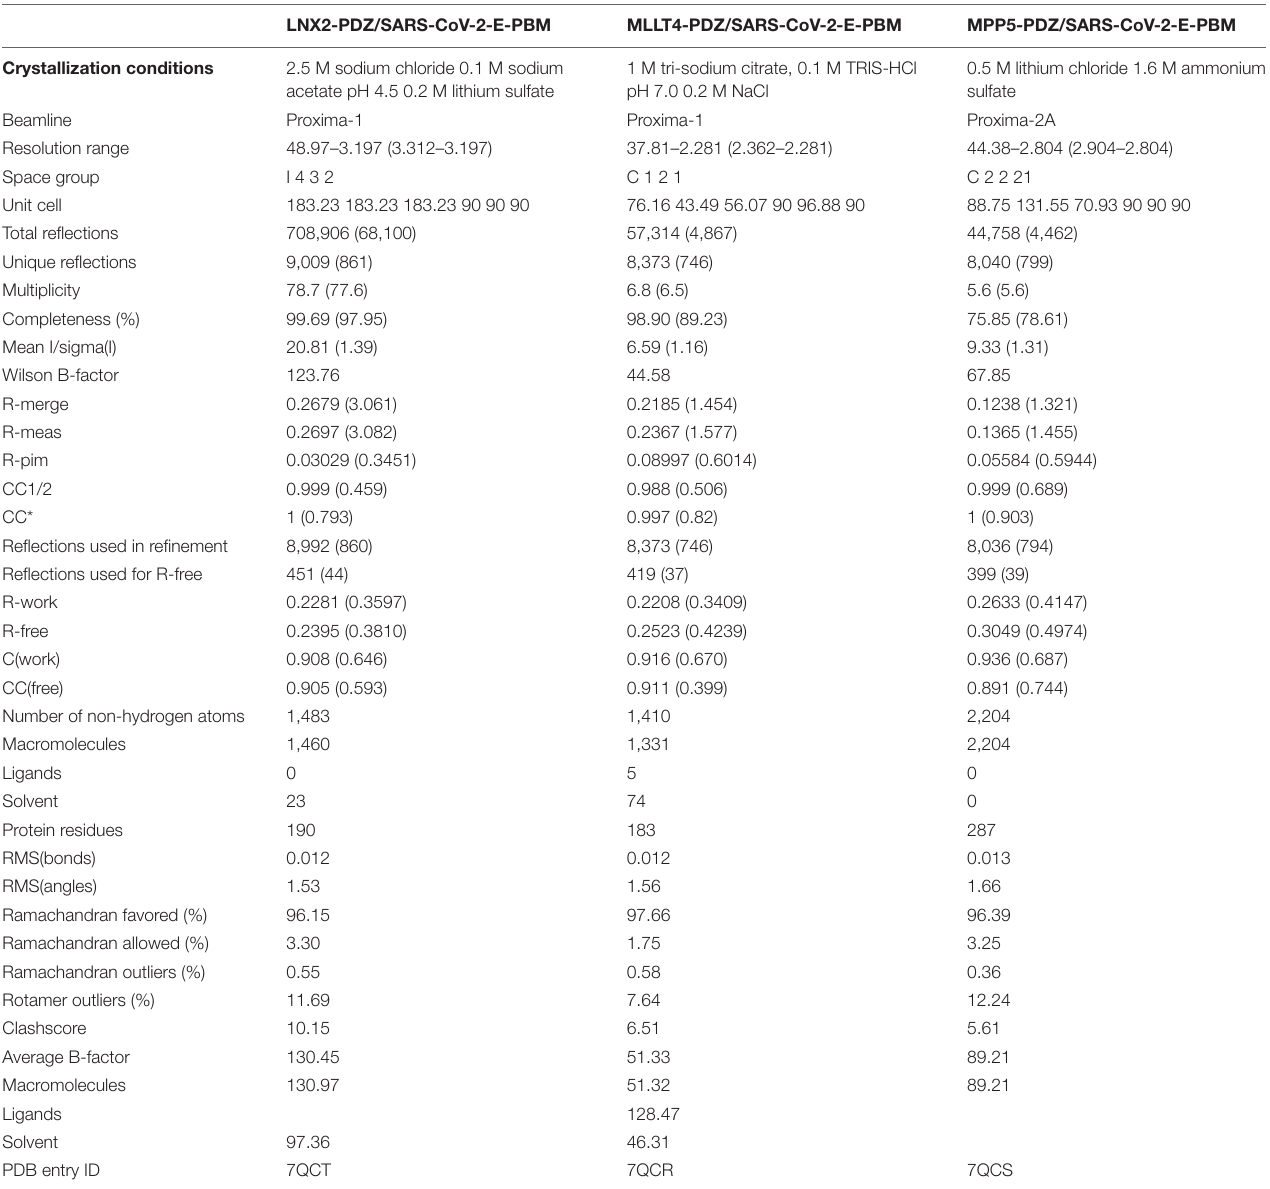
TABLE 2 | X-ray data collection and refinement